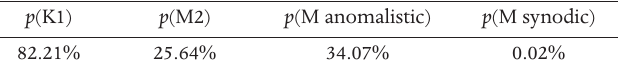
Table 3. The confidence levels of the earthquake–Earth tide correlations for all the earthquakes in the present study.